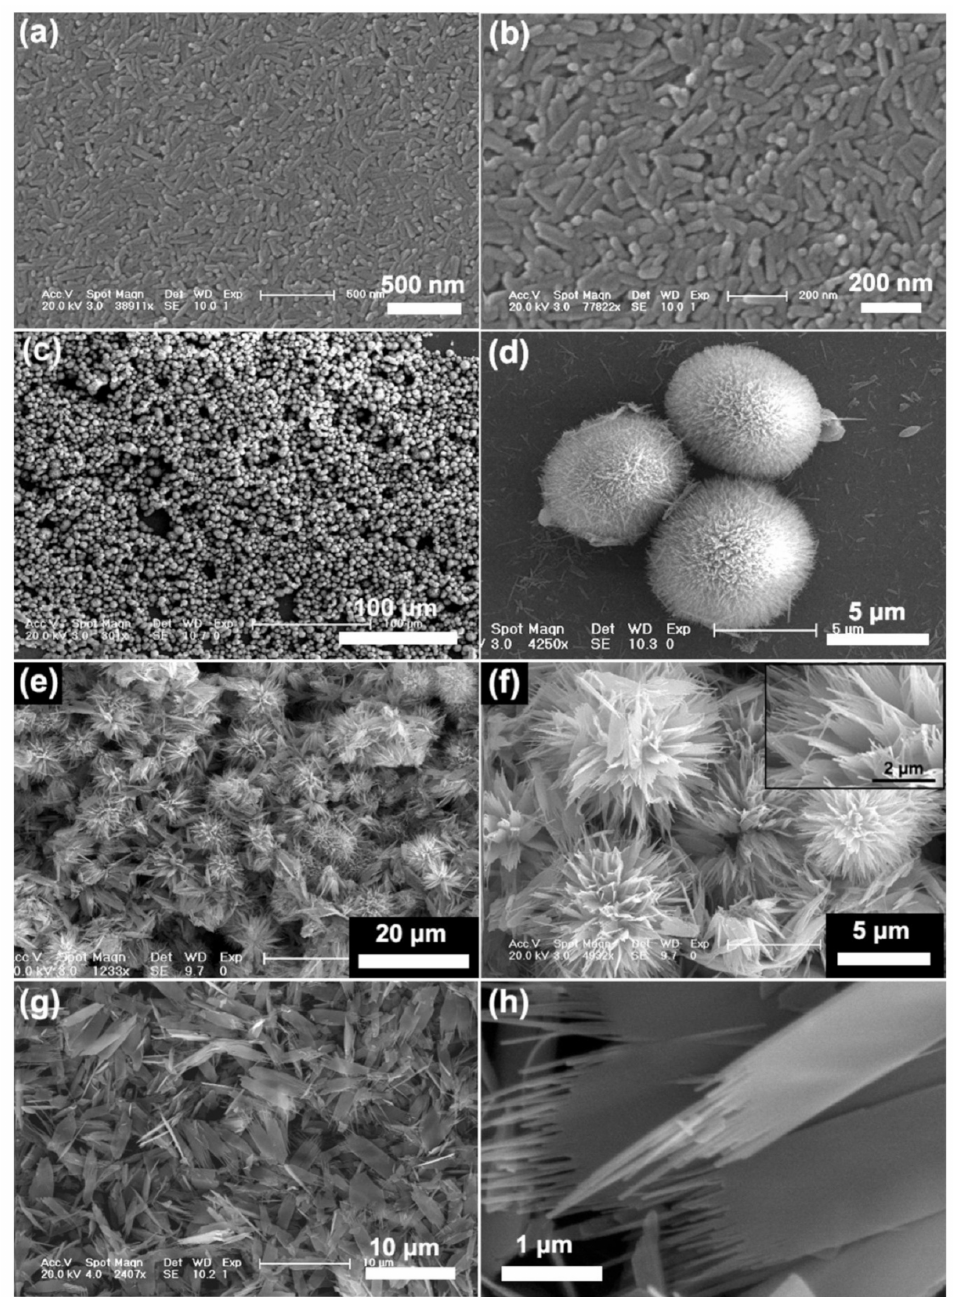
Figure 6. Nanorod ( a , b ), bur-like microsphere ( c , d ), microflower ( e , f ) and microsheet ( g , h ) morpholo- gies that can be obtained from precipitation media having pH values of 7.0, 5.0, 4.5 and 4.0, respectively. Reproduced from [53] with permission from the American Chemical Society. Copyright ©